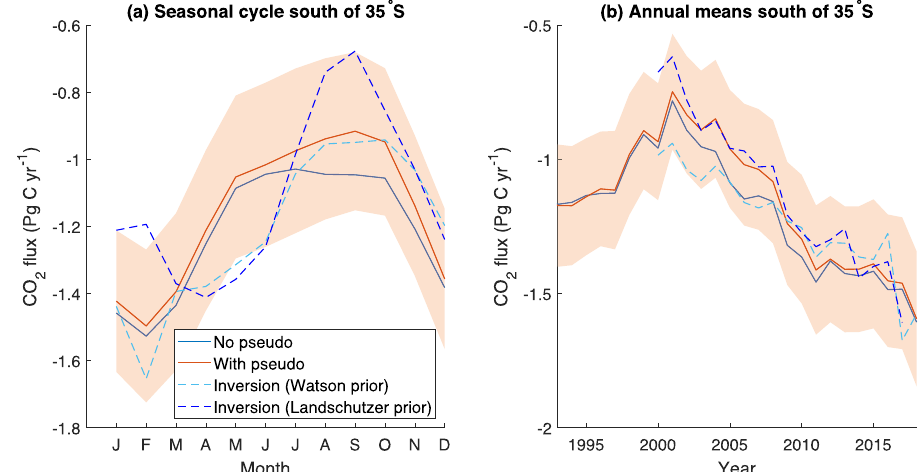
Fig. 5 Air-sea CO 2 fl uxes for the Southern Ocean. a 2000 – 2017 mean seasonal cycle and b annual mean air-sea CO 2 fl uxes (negative into the ocean) for the Southern Ocean south of 35°S based on sea surface fCO 2 from the SOM-FFN with and without pseudo observations. Values are Petagrams of carbon per year (Pg C yr − 1 ). Each line represents an ensemble mean, and the shaded area is the 1- σ uncertainty on the SOM-FFN result with pseudo observations (see Methods). Also plotted are the same quantities derived from an atmospheric inversion using two different priors (dashed lines; see Methods section). Note that unlike Fig. 3, the mean seasonal cycle is plotted for a shorter time period, for consistency with the atmospheric